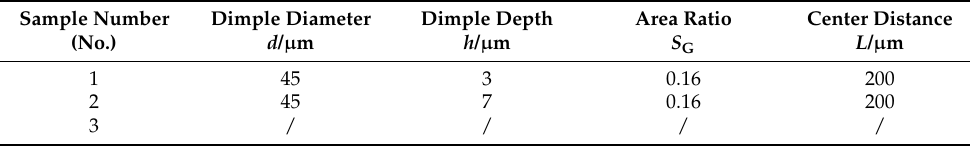
Table 3. Parameters of samples.